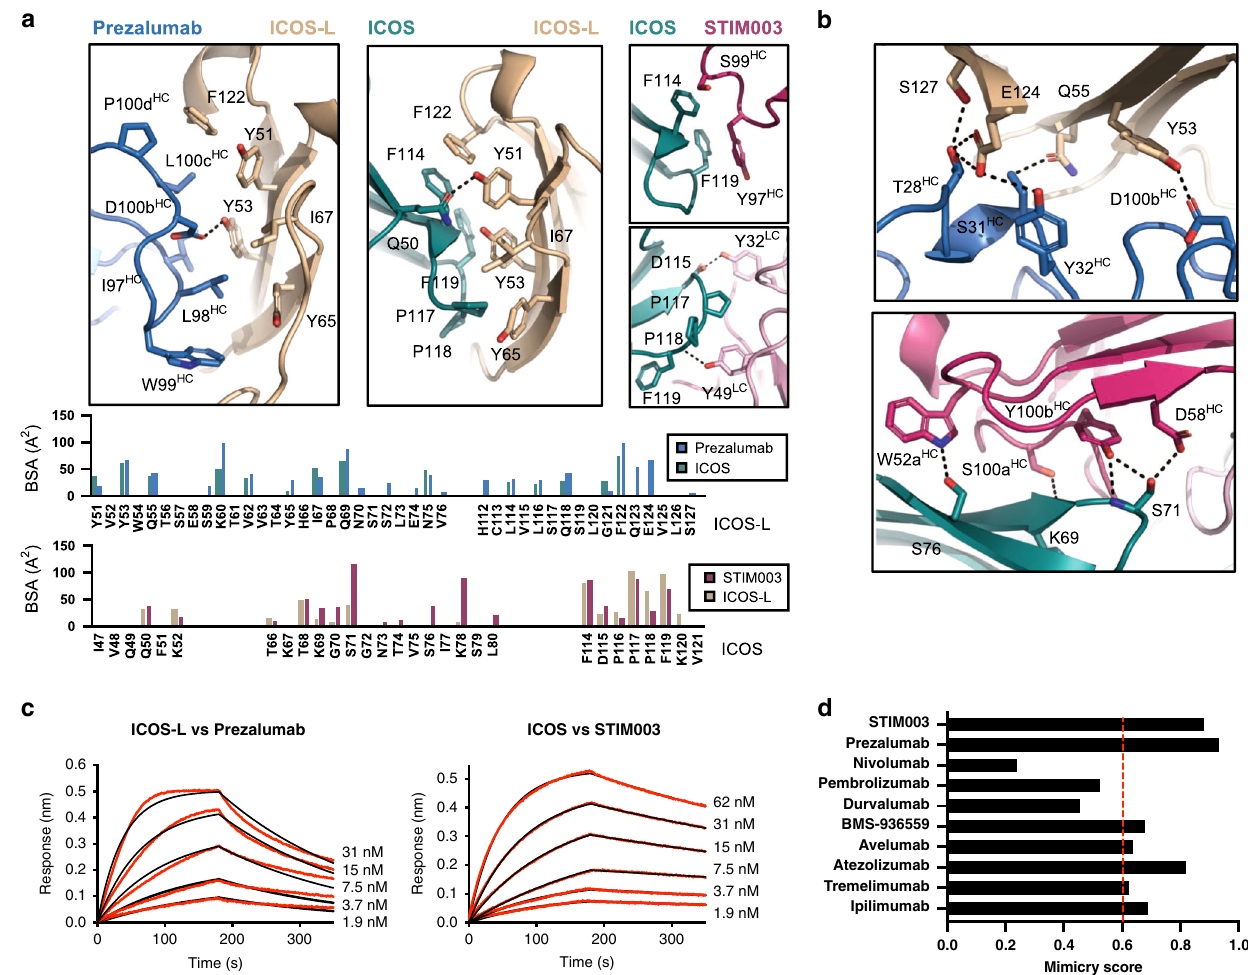
Fig. 6 Remarkable receptor mimicry by antibodies targeting ICOS/ICOS-L. a Antibody mimicry of the main hydrophobic/aromatic interface of the ICOS/ ICOS-L complex by STIM003 and prezalumab. HCDR3 of prezalumab mimics the FG loop of ICOS to mediate interaction with ICOS-L (left panel). STIM003 interactions with the FG loop of ICOS are mediated by residues from HCDR3, LCDR1 and LCDR2 (right panels). Critical residues for binding are shown in sticks and the BSA of these and the rest of residues involved in binding are plotted (bottom). The BSA of the ICOS/ICOS-L interaction is included for direct comparison. b Additional H-bonds (black dashes) between the antibodies and ICOS and ICOS-L in areas outside the core interface of the receptor/ligand complex. c Kinetics of prezalumab and STIM003 binding to ICOS-L and ICOS, respectively. d Comparison of binding mimicry by therapeutic antibodies targeting the CD28/B7 superfamily calculated as the fraction of residues with >1 Å 2 of BSA of the receptor/ligand pair that are contacted by antibody binding as detailed in Supplementary Fig. 5. Color coding is as in Fab expression and puri fi cation . The Fab heavy and light chains of STIM003 and prezalumab were cloned into custom pcDNA3.4 expression vectors at GeneArt (Life Technologies). Fabs were transiently expressed in 200 mL HEK 293F cells (ThermoFisher Scienti fi c) by co-transfecting 90 μ g of the LC and the HC in a 1:2 ratio with FectoPRO (Polyplus Transfections). Puri fi cation of the Fabs was per- formed using a KappaSelect af fi nity column (GE Healthcare) and 100 mM glycine pH 2.2 as the elution buffer. Eluted fractions were immediately neutralized with 1 M Tris-HCl pH 9.0 and further puri fi ed using a MonoS ion exchange column and a Superdex 200 Increase size exclusion column (GE Healthcare).